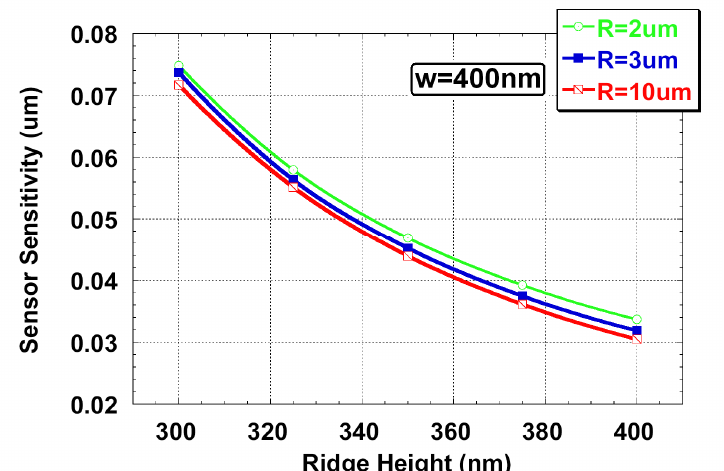
Figure 3. Device sensitivity versus ridge height, numerically estimated by formula (6) (quasi-TM